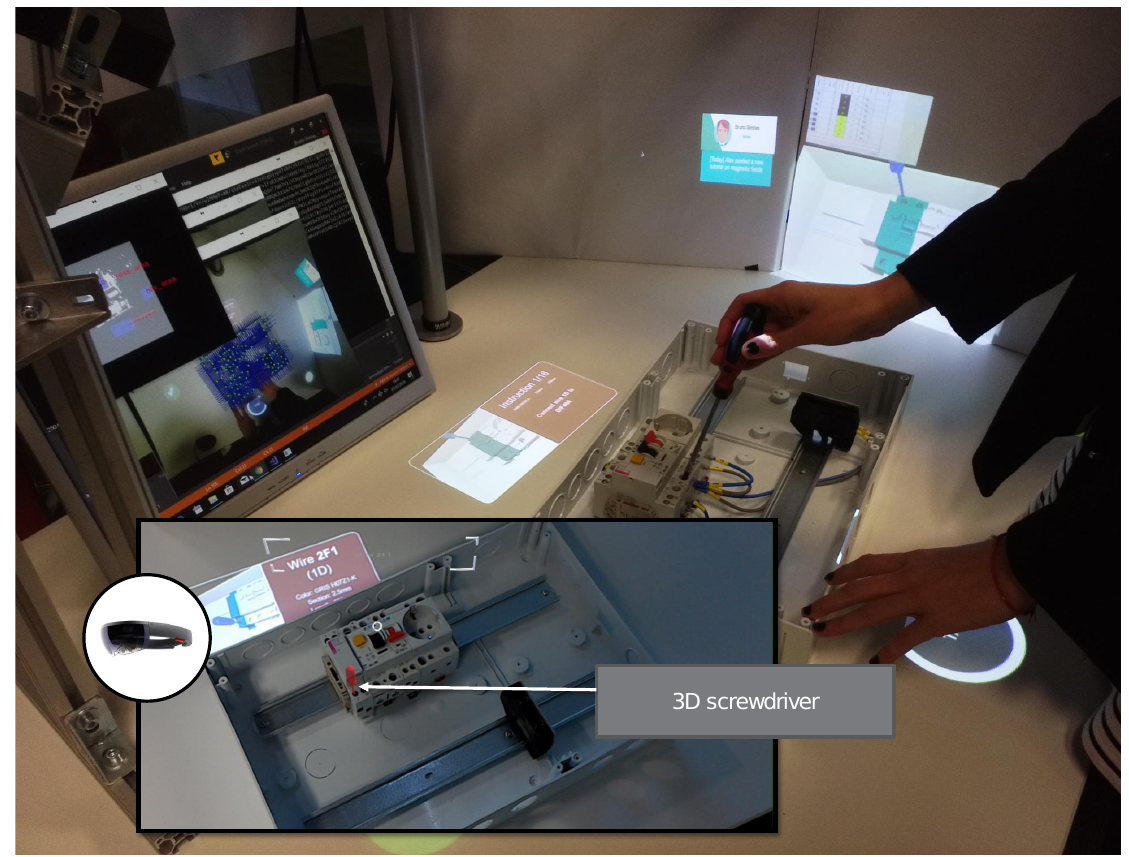
Figure 6. Multimodal use